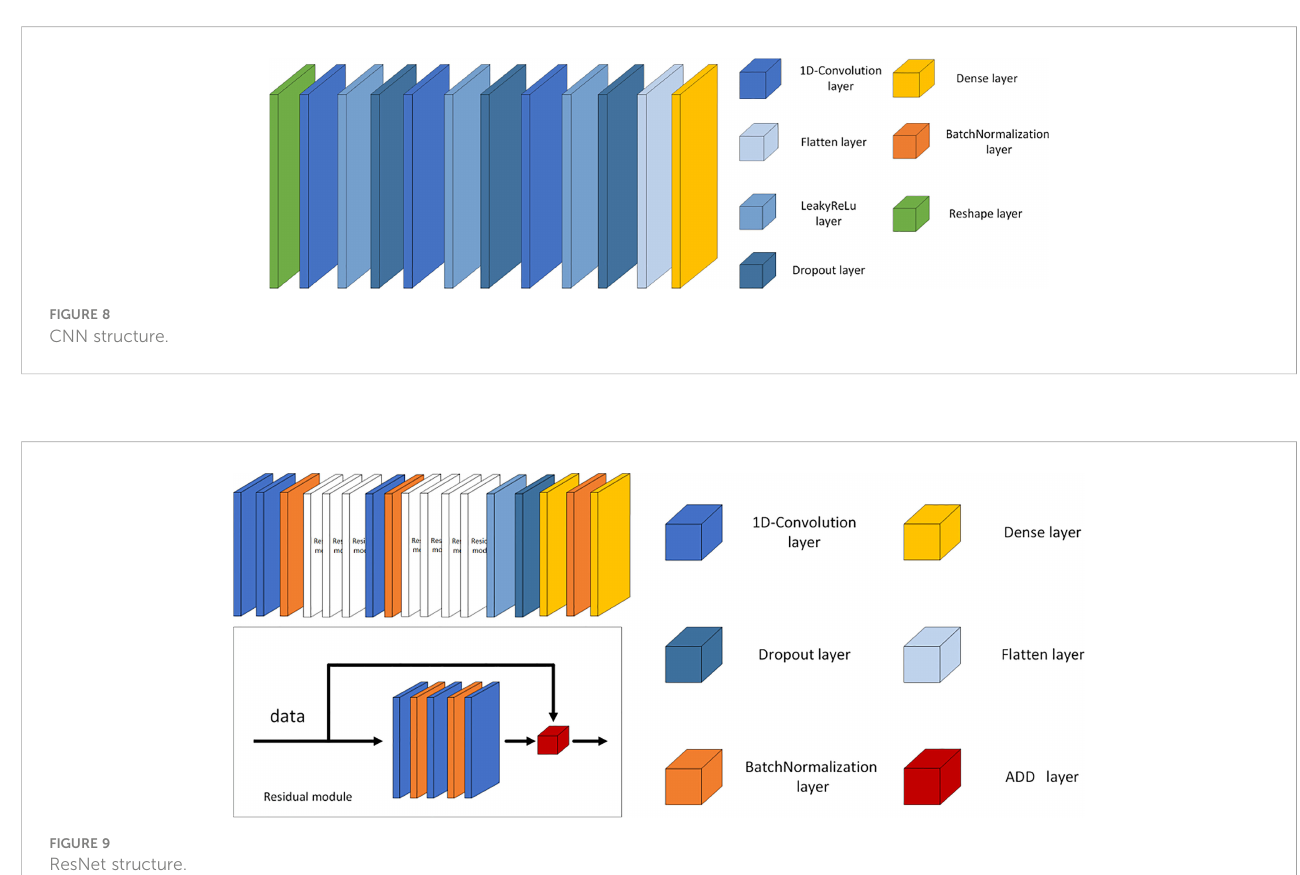
Figure11Dwhentheratiooftheoriginalsampletothenumberofgenerated samplesis1:1.Finally,theaccuracyreached99.17%inFigure11Ewhenthe ratiois1:2.Intheprocessofnetworkmodeltrainingandtesting,eachepoch took about 16 seconds. The number of epochs needed for convergence is reduced from 150 to 50 on testing set, and the convergence time is reduced from40minutesto13.3minutes.Afternetworktrainingiscompleted,when the new ship-radiated noise data are obtained, we only needed to perform sample segmentation and input them into the network directly without complex signal decomposition and manual feature extraction for classi fi cation. A classi fi cation result with an accuracy of 99% could be obtained within a few